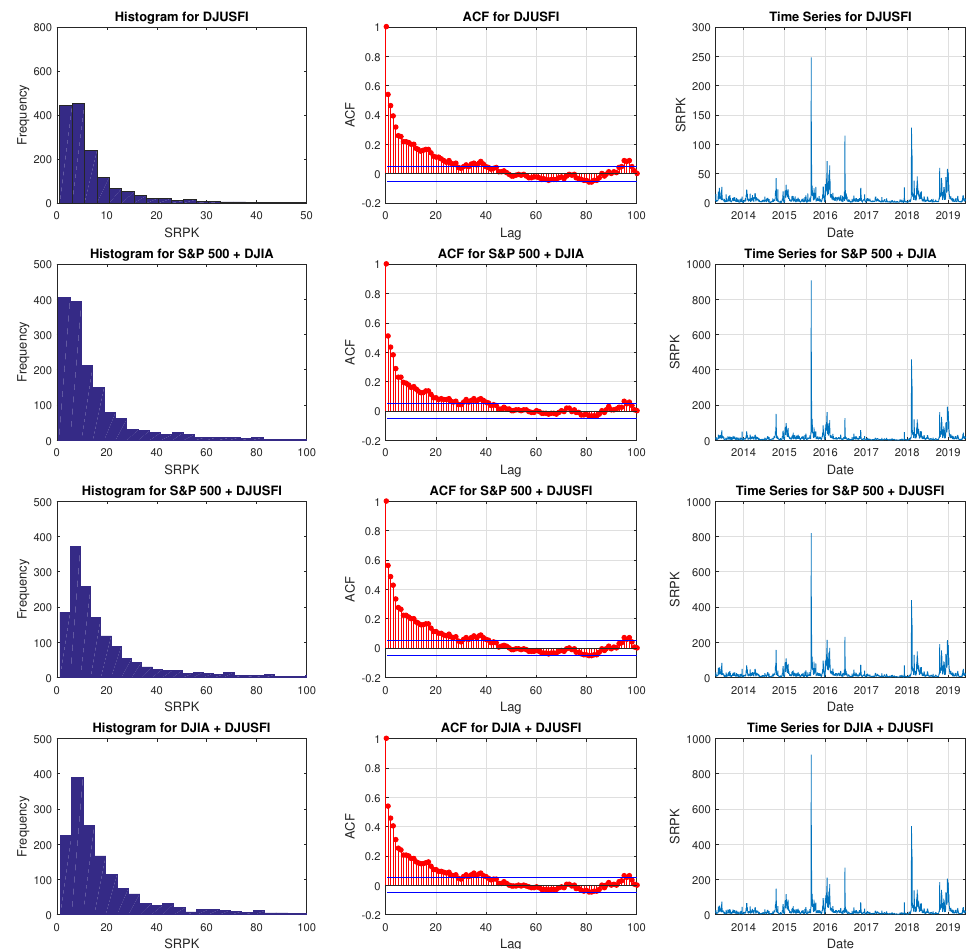
Figure 1. Histogram, ACF and time series plots for SRPK measures from 1 May 2013 to 31 May 2019 with S&P 500, DJIA, DJUSFI and their pairwise sum